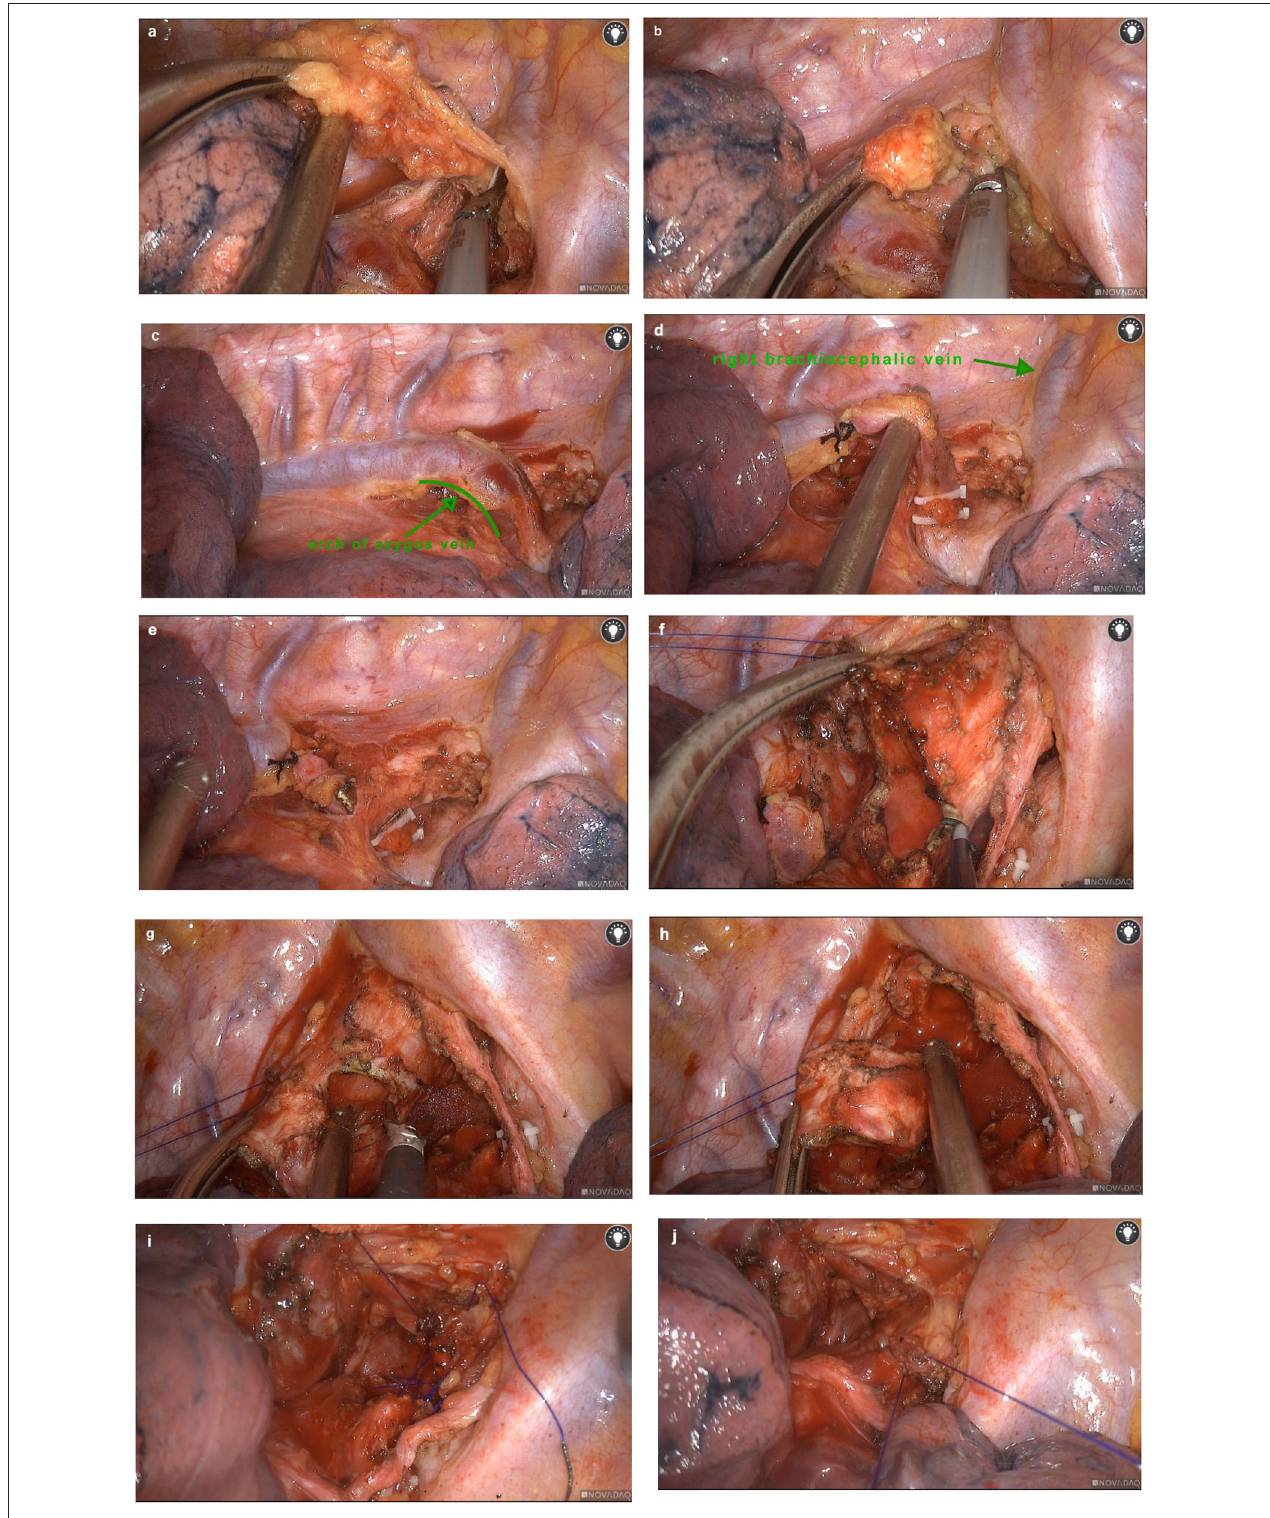
FIGURE 2 | Surgical procedures. We used an electric hook and an ultrasonic knife to clean up the upper paratracheal lymph nodes (a,b) . The azygos vein was exposed (c) , ligated (d) and divided (e) . After exposing the intact upper trachea, we cut the end of the tumor in the upper trachea (f) . Then we cut the the trachea at the beginning of the tumor (g) to remove the tracheal segment where the tumor was located completely (h) . Absorbable sutures were used for continuous sutures to connect the tracheal margins at both ends (i,j) .